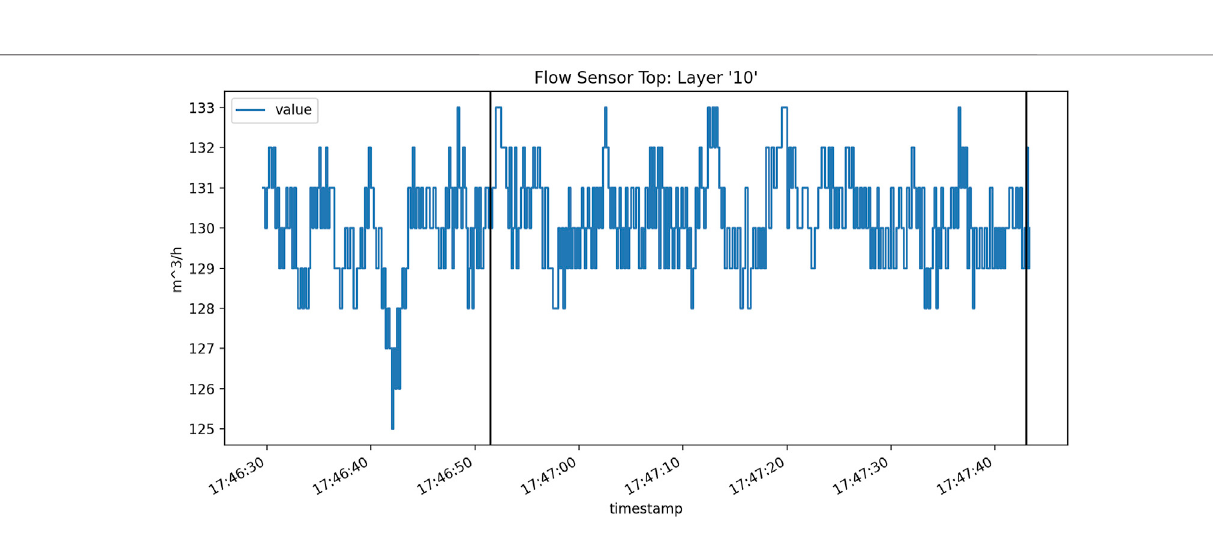
Frontiers in Mechanical Engineering |